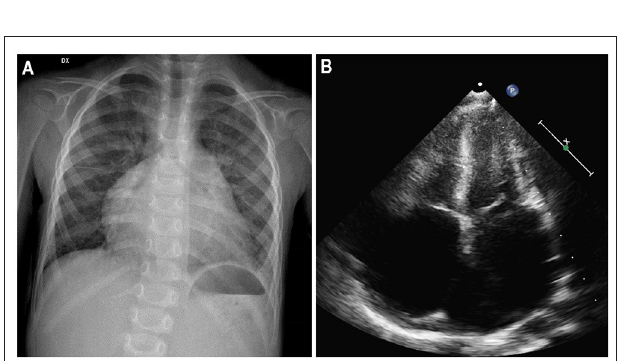
FIGURE 5 | Three-year-old girl affected by restrictive cardiomyopathy. Antero-posterior chest radiograph (A) showing massive cardiomegaly due to severe biatrial enlargement, as confirmed by apical four-chamber echocardiography (B)